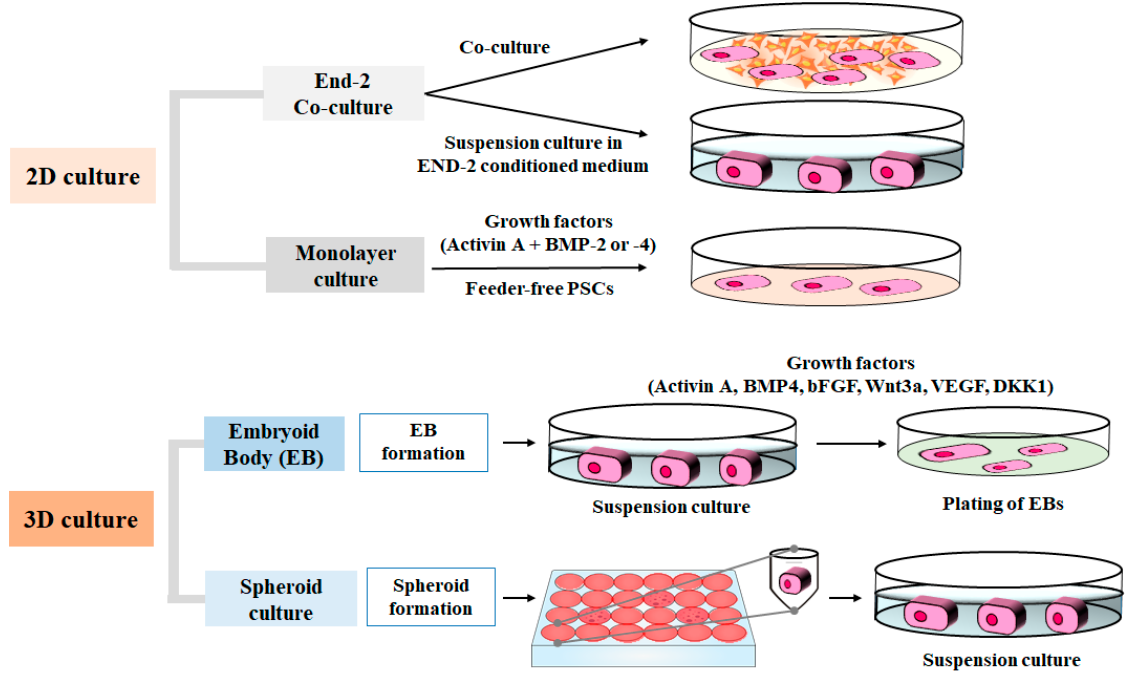
Figure 1. Differentiation induction into cardiomyocytes from pluripotent stem cells (PSCs) using two-dimensional (2D) or three-dimensional (3D) culture.